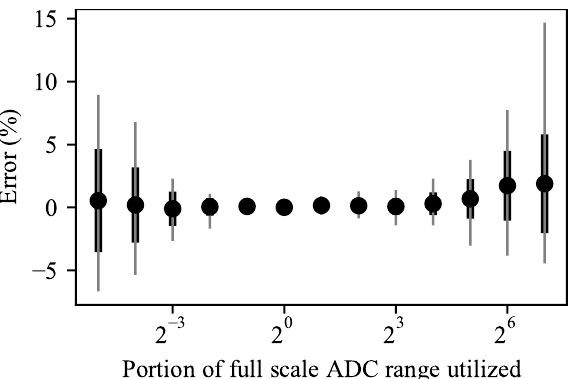
Figure 8. Measurement accuracy for saturated and nonsaturated measurements. Graph shows average, extremes, and standard deviation when measuring above and below the full ADC range with constant noise. (Reproduced from [17] with permission from